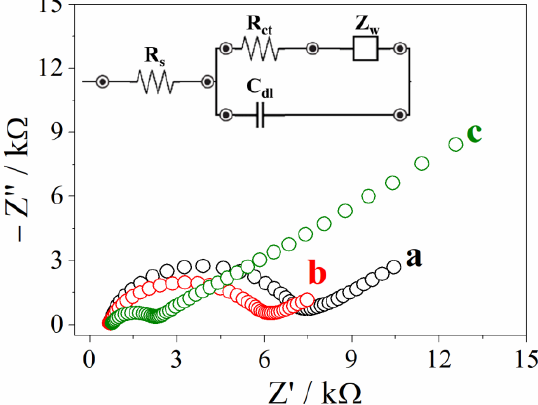
Figure 3. Nyquist plots for 5.0 mmol L −1 equimolar mixture of K 3 [Fe(CN) 6 ]/K 4 [Fe(CN) 6 ] in 0.1 mol L −1 KCl: (a) CPE, (b) PCF-qnz/CPE, and (c) PBA-qnz/CPE. We inserted the Randles circuit model for the electrodes. R s : solution resistance; R ct : charge-transfer resistance; Z w :